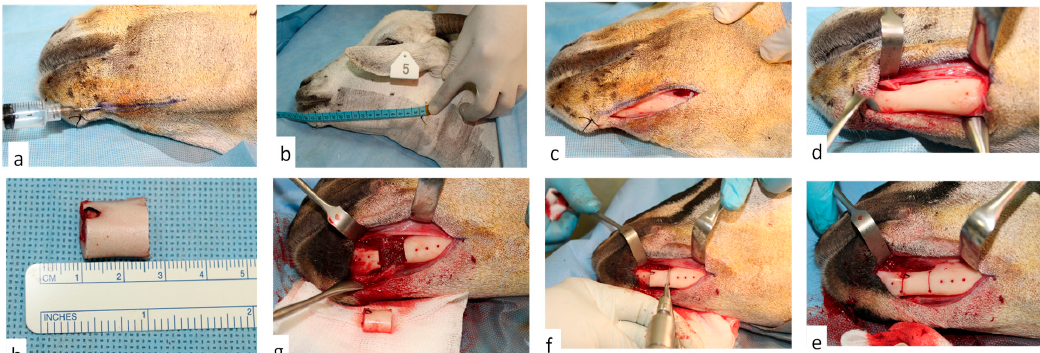
Figure 7. Surgical process: ( a ) Performing general anesthesia, ( b ) measuring the mandibular length from angle to symphysis, ( c ) linear incision was performed, ( d ) extended the linear incision, ( e ) marking experimental segmental defect, ( f ) performing osteotomy using a reciprocating saw, ( g ) removing the bony segment and ( h ) measuring the bony segment.